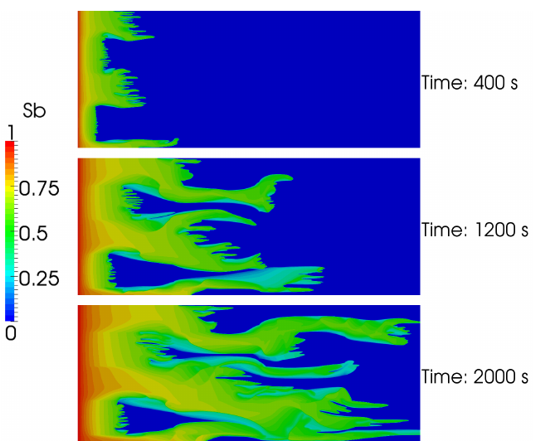
Figure 11. An illustration of viscous fingering in heavy oil reservoir, here, Sb denotes water saturation (Horgue, et al., 2015). (Reprinted with permission from Horgue, et al., 2015